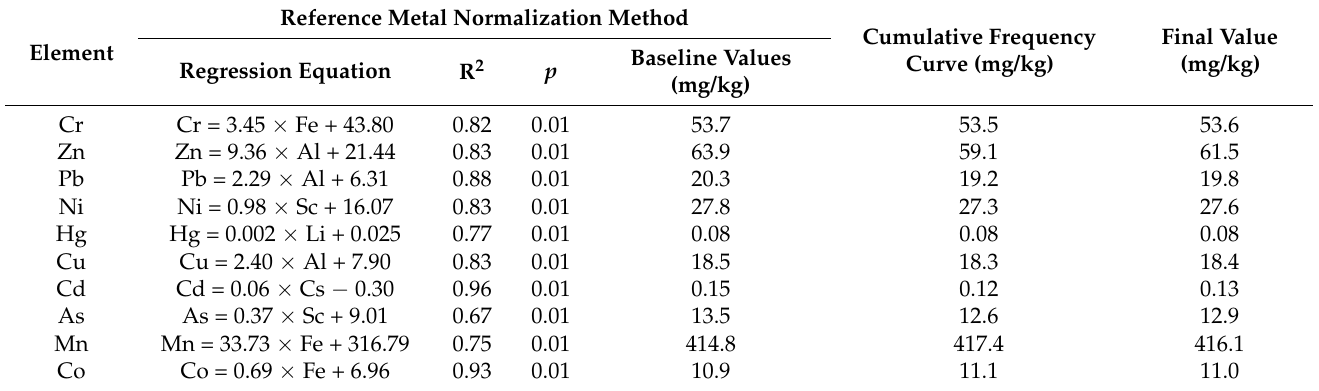
Table 3. The regression equations and GBVs for the studied HMs.